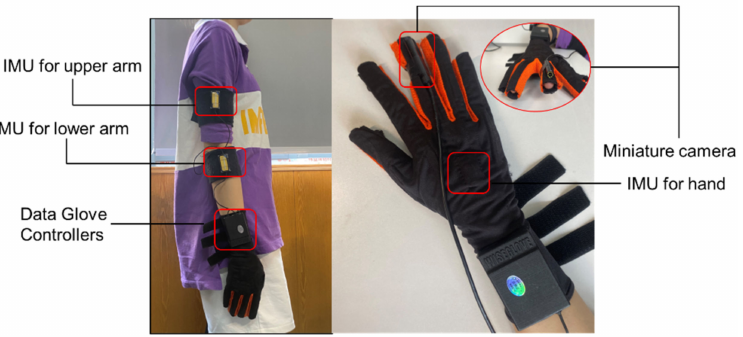
Figure 1. Sensor installation